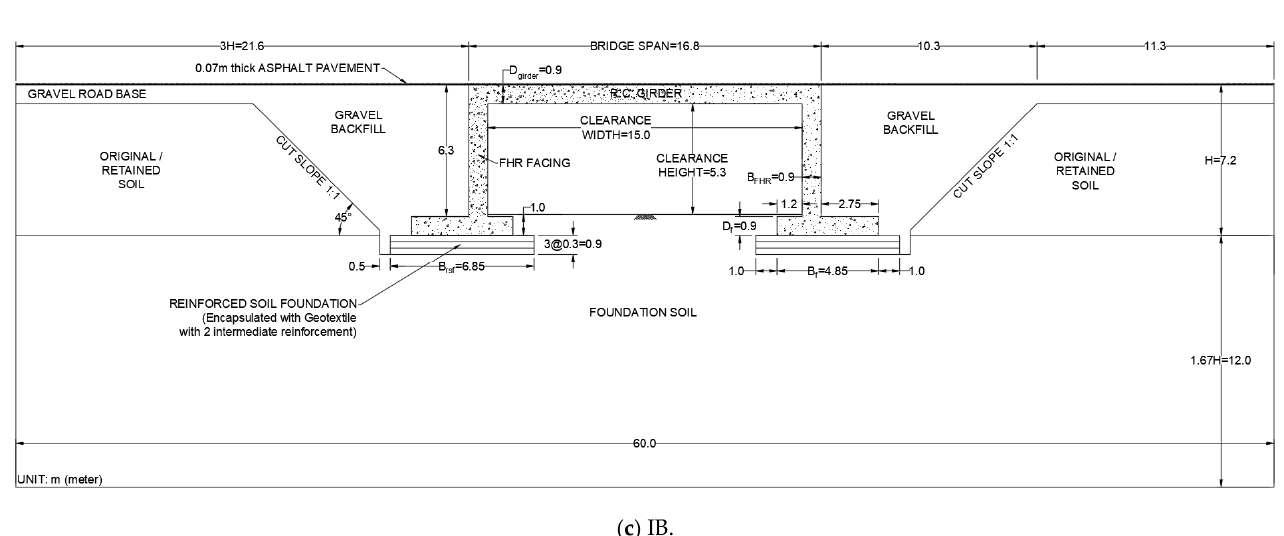
Figure 3. Design details of each model case: ( a ) GRS-IB; ( b ) GRS-IBS; and ( c ) IB Model.